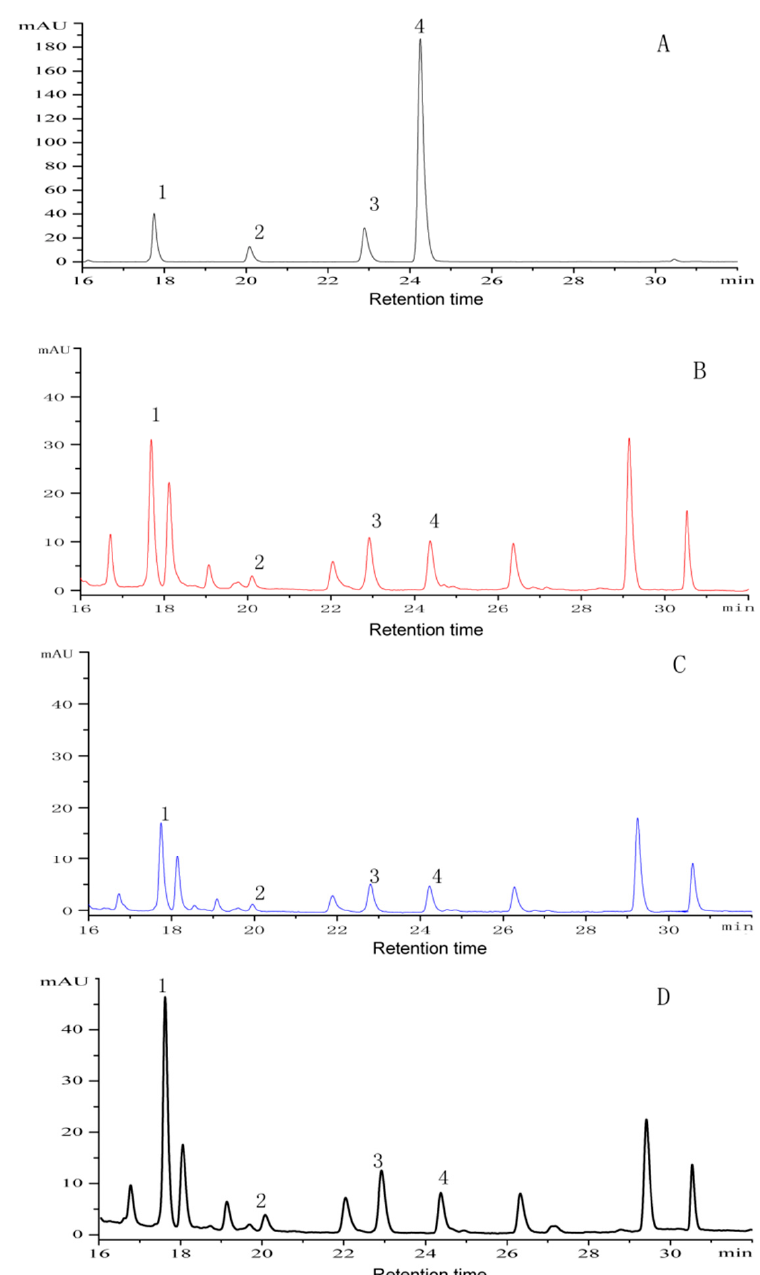
Figure 6. HPLC chromatograms of four anthraquinones in Cassiae Semen ( A ) standard solution of four anthraquinones, ( B ) extracted using heating reflux extraction, ( C ) extracted using normal miniaturized MSPD, ( D ) extracted using VS-MSPD. Peaks: 1 = Aurantio-obtusin, 2 = Chryso-obtusin, 3 = Obtusifolin, 4 = Emodin.